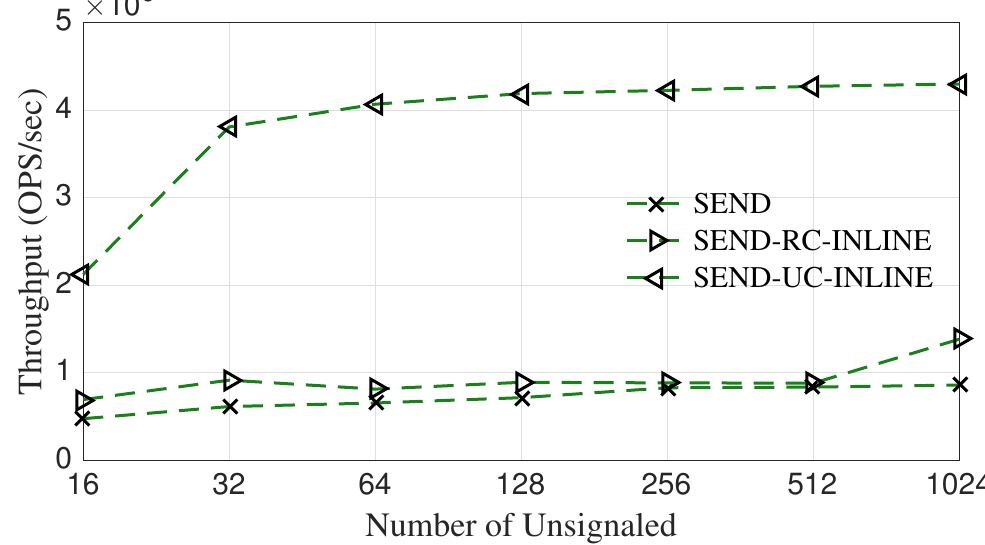
Figure 8. Inline and connection type impact on the SEND performance.